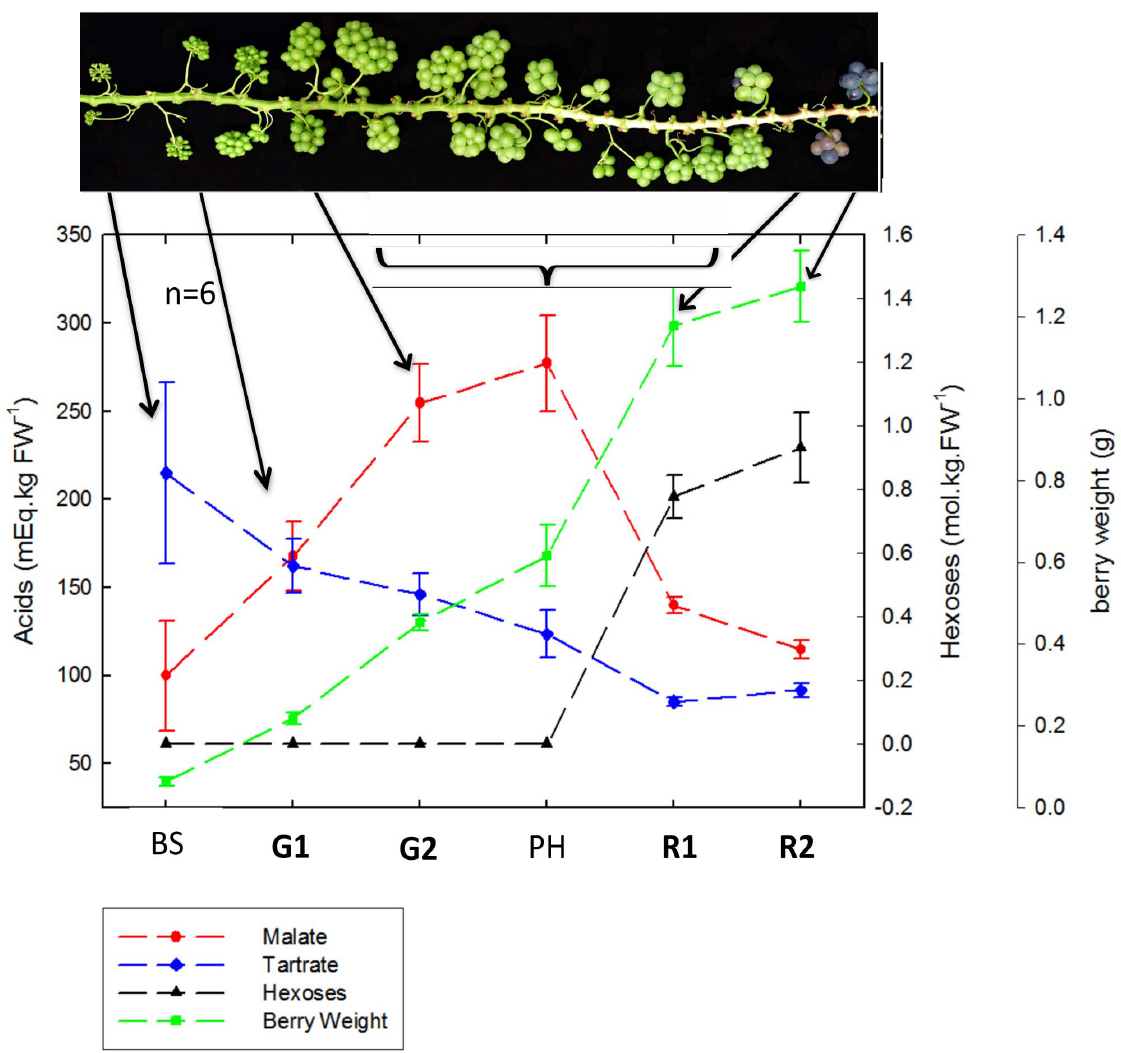
Figure 1. Main biochemical characteristics of sampled berries. BS: Berry Set, G1: Green stage 1, G2: Green stage 2, PH: Plateau Herbace´/lag phase, R1: Ripening stage 1, R2: Ripening stage 2.